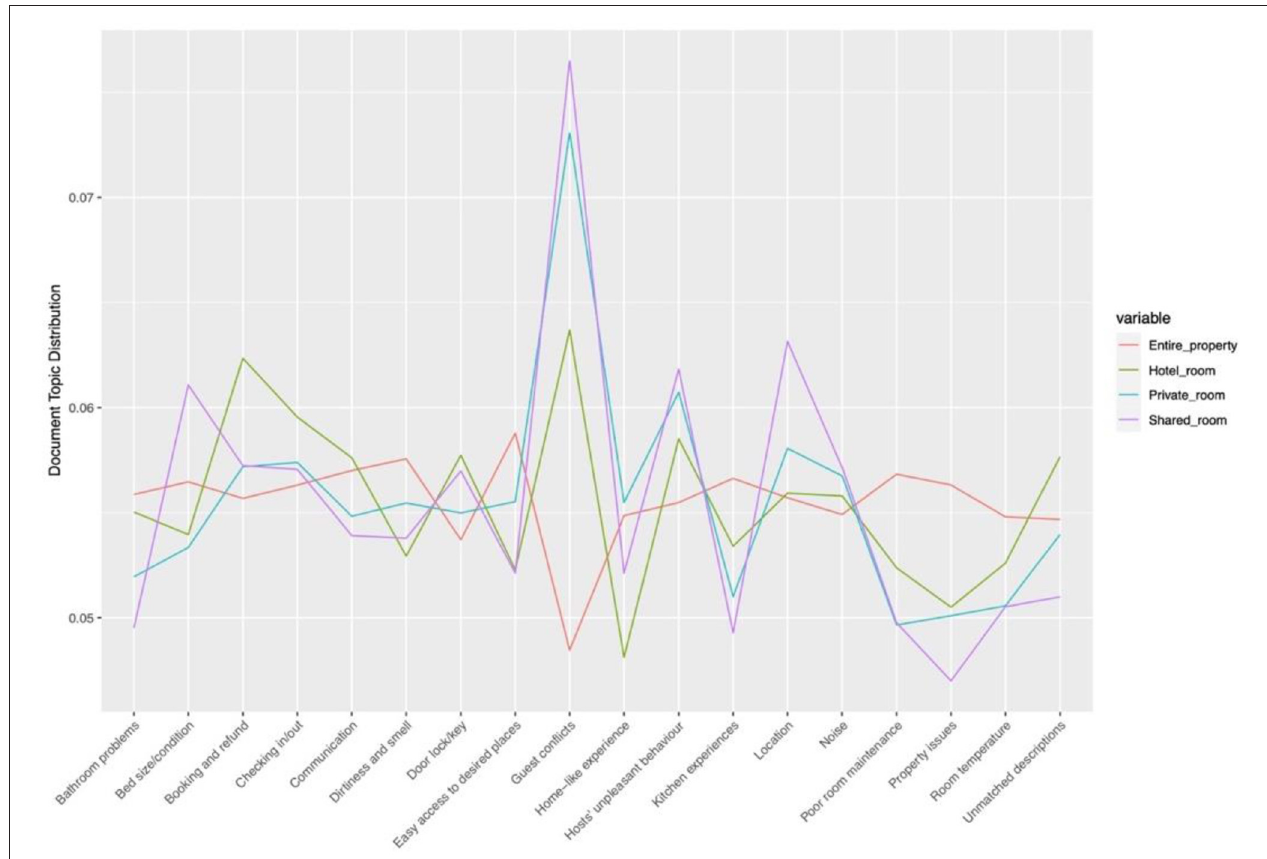
FIGURE 8 | Topic distributions in different Airbnb properties (negative reviews). Source: created by the authors.